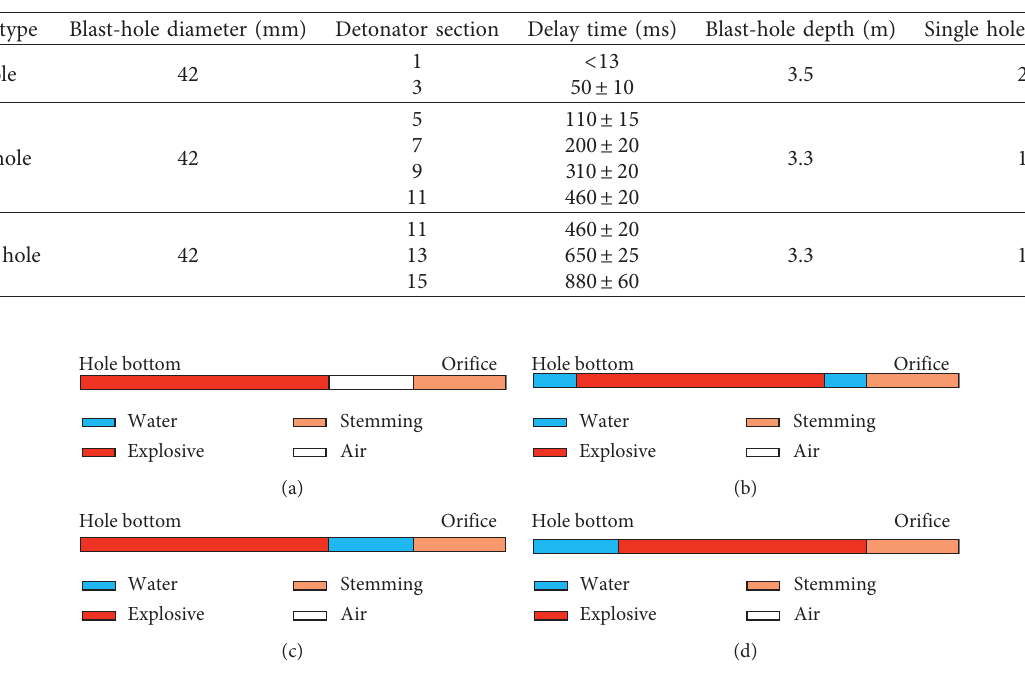
Figure 3: Blast-hole arrangement and detonation sequence. Table 2: Main blasting parameters of the upper bench.